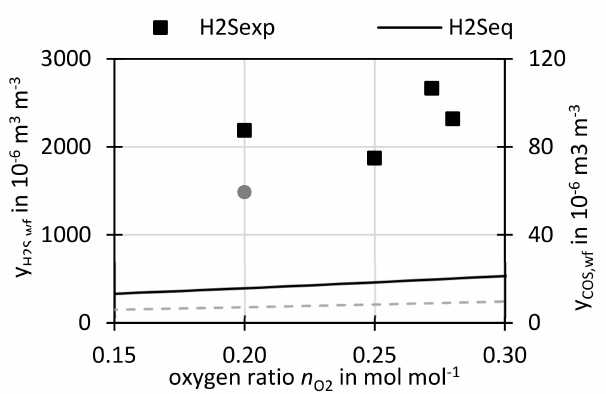
Figure 11. Measured and equilibrium H 2 S and COS concentrations on dry and N 2 -free basis at different oxygen ratios n O2 and constant ϑ